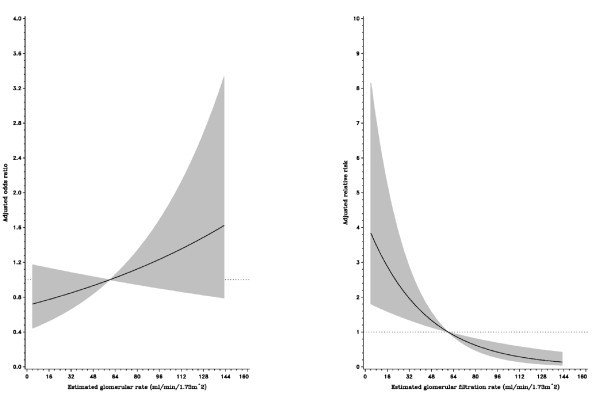
Relationship between glomerular filtration rates and the risk of acute coronary syndrome event (left) and all-cause death after event (right). The multivariate adjusted relative risks were plotted as a function of the baseline glomerular filtration rate with the 95% confidence bands shown as the shaded area.